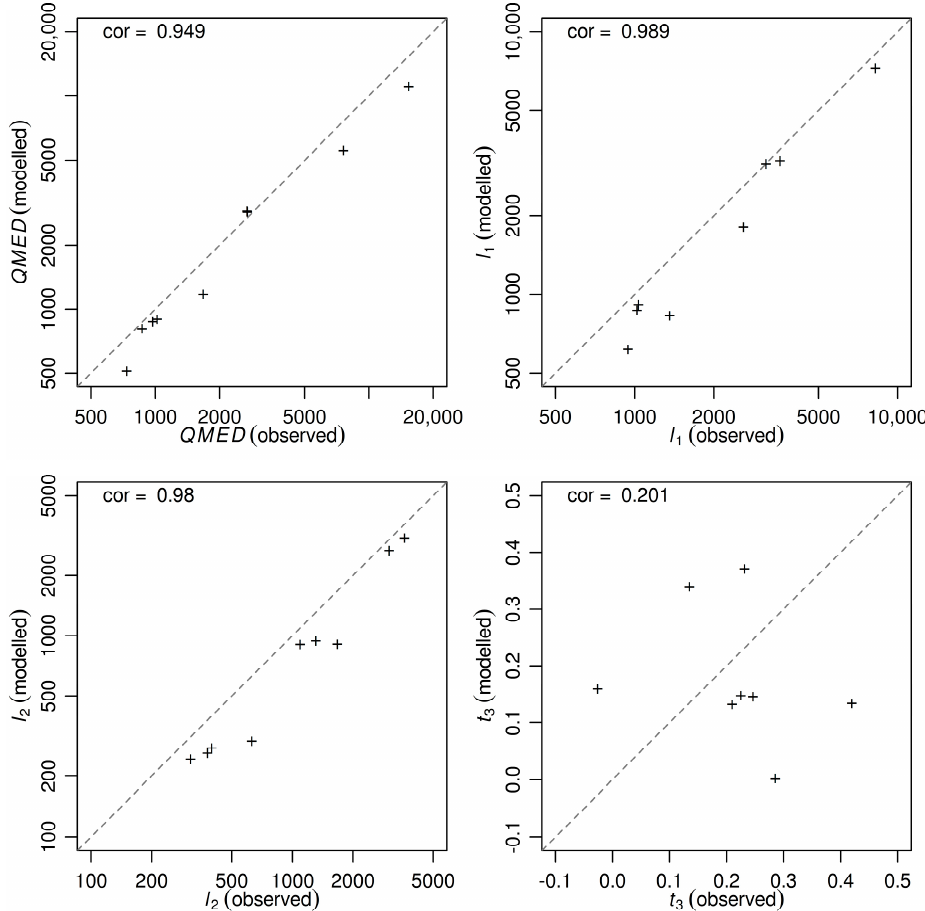
Figure 5. Modeled vs observed QMED , l 1 (sample L -mean), l 2 (sample L-CV ) and t 3 (sample L - SKEW ) for nine Wainganga station AMAX records.